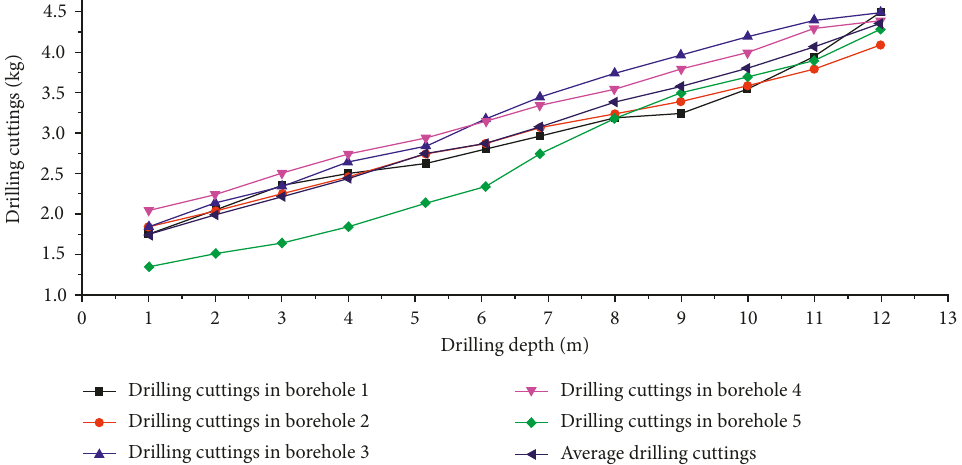
Figure 6: Drilling cuttings at affected area by mining.